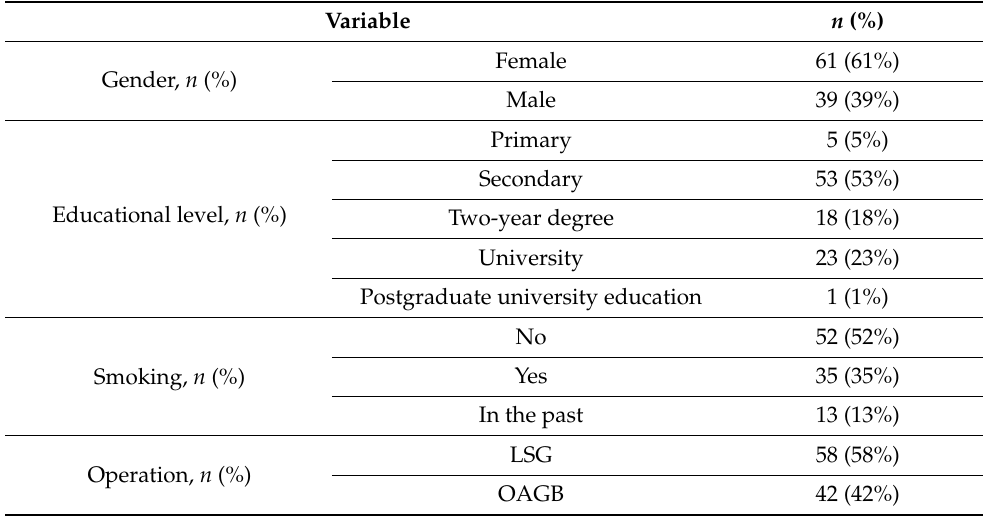
Table 1. Information about the surgical procedure and descriptions of general and demographic features of the study sample.